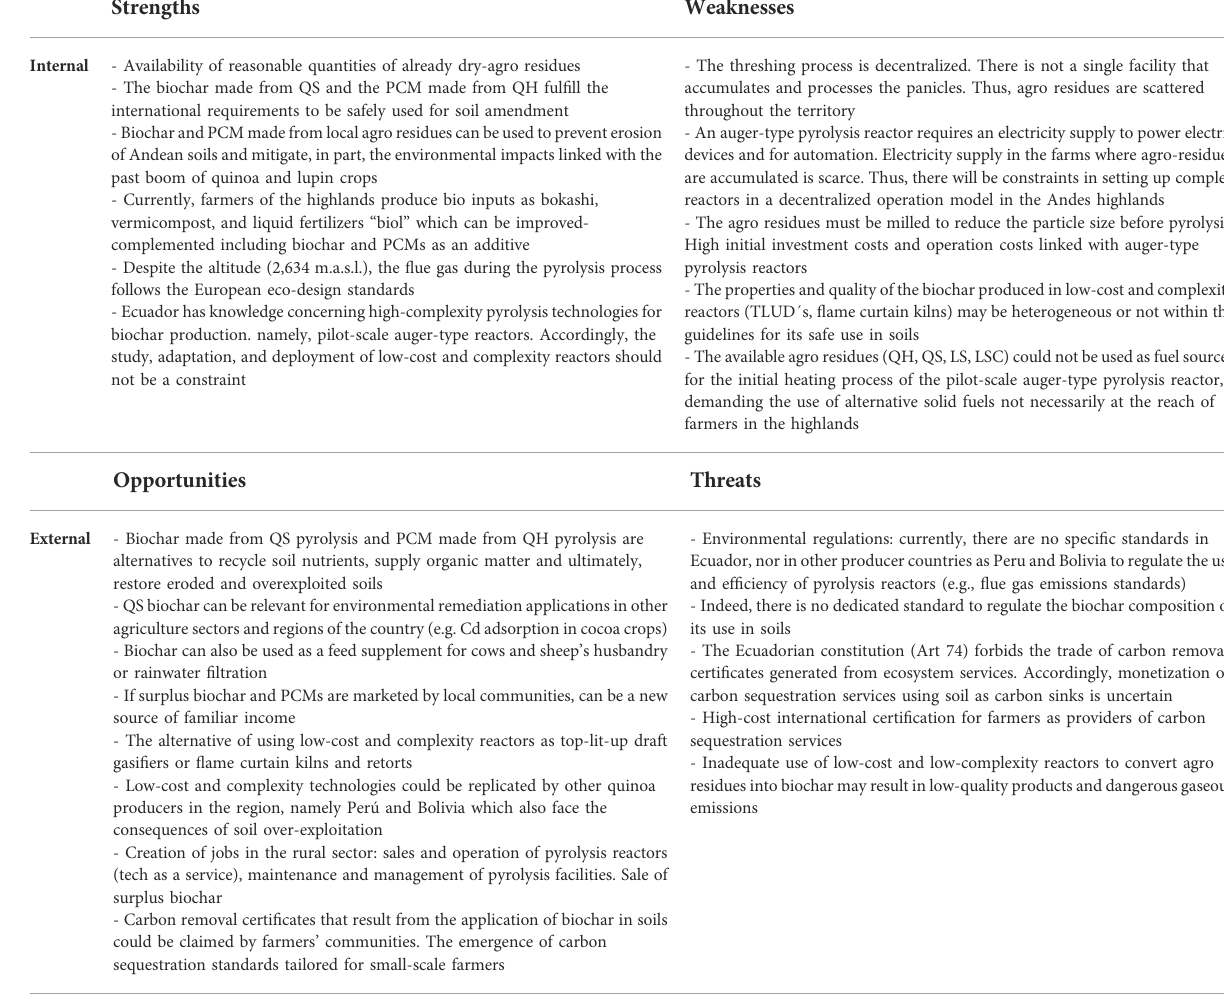
TABLE 6 Results of a SWOT analysis that explore the constraints and prospects concerning the conversion of agro-residues produced during the post-harvesting processes of Quinoa and Lupin into biochar for soil amendment in the Andes highlands.